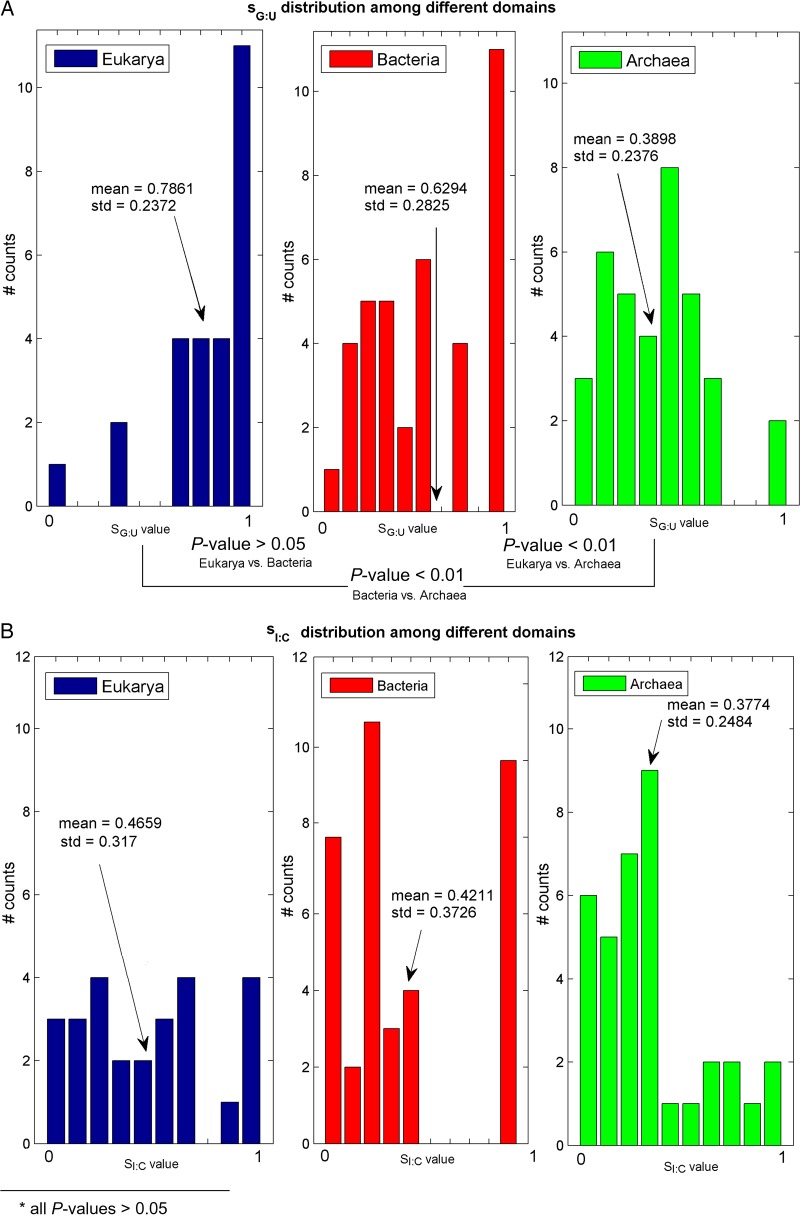
Sij distributions among different domains of life. Each figure contains three histograms representing the Sij in the different domains of life; the mean and SD of the Sij-values in each domain are also reported. The P-values corresponding to the comparison between every two Sij means appear in the bottom of the figure (see section 2 sub-section ‘Permutation test for comparing two Sij means’).